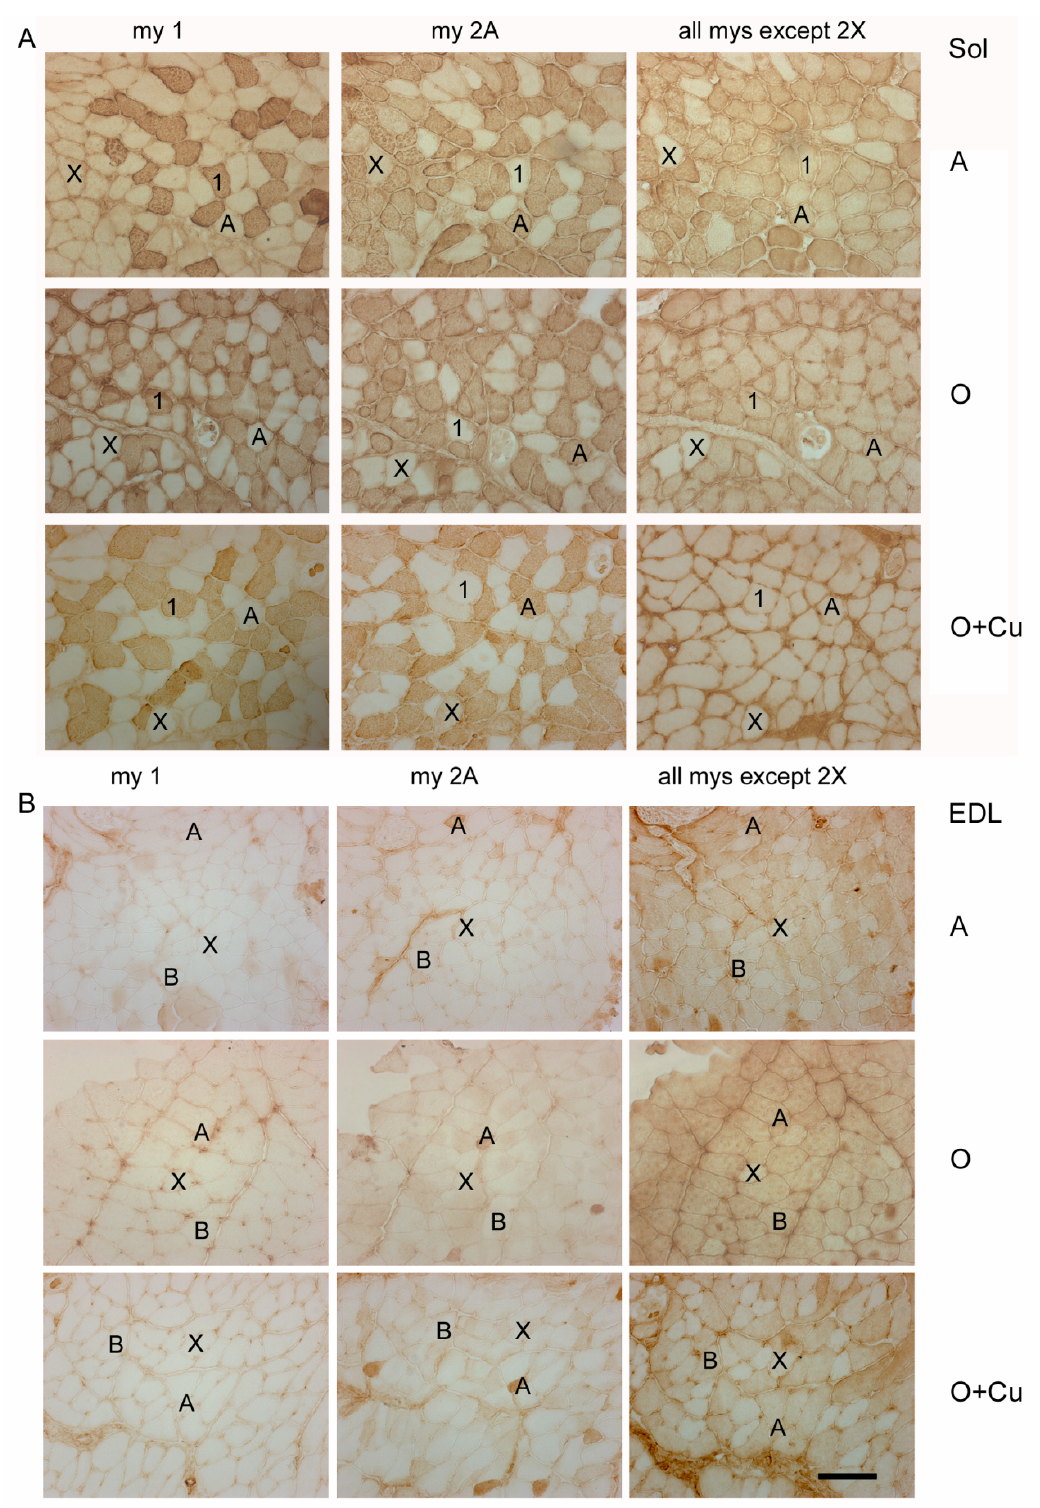
Figure 4. Representative immunoperoxidase stainings with anti-myosin (my) antibodies of serial cryosections of soleus (Sol) (panel ( A )) and EDL (panel ( B )) obtained from adult 10ScSn mice (A) and old ones, after either vehicle (O) or curcumin administration (O + Cu). Type-1 and -2A myofibers were identified after staining with anti-my-1 or anti-my-2A antibodies, respectively, whereas type-2X myofibers were identified indirectly, by the absence of staining with antibodies for my-1 and my-2A and with the BF-35 antibody, which reacts with every myosin type except 2X [21]. Type-2B myofibers were identified by the absence of staining for my-1 and my-2A and the presence of staining with BF-35 antibody. Bar: 100 μ m.